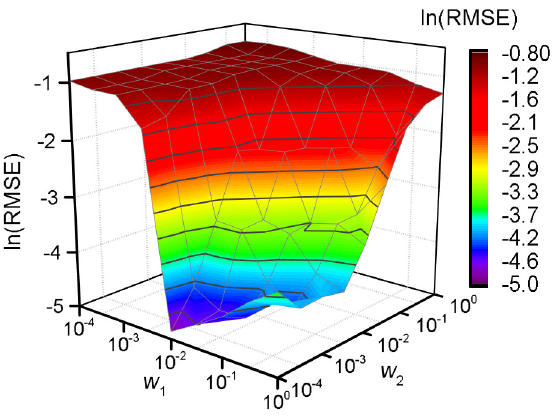
Figure 3. Model generalization ability of different weights’